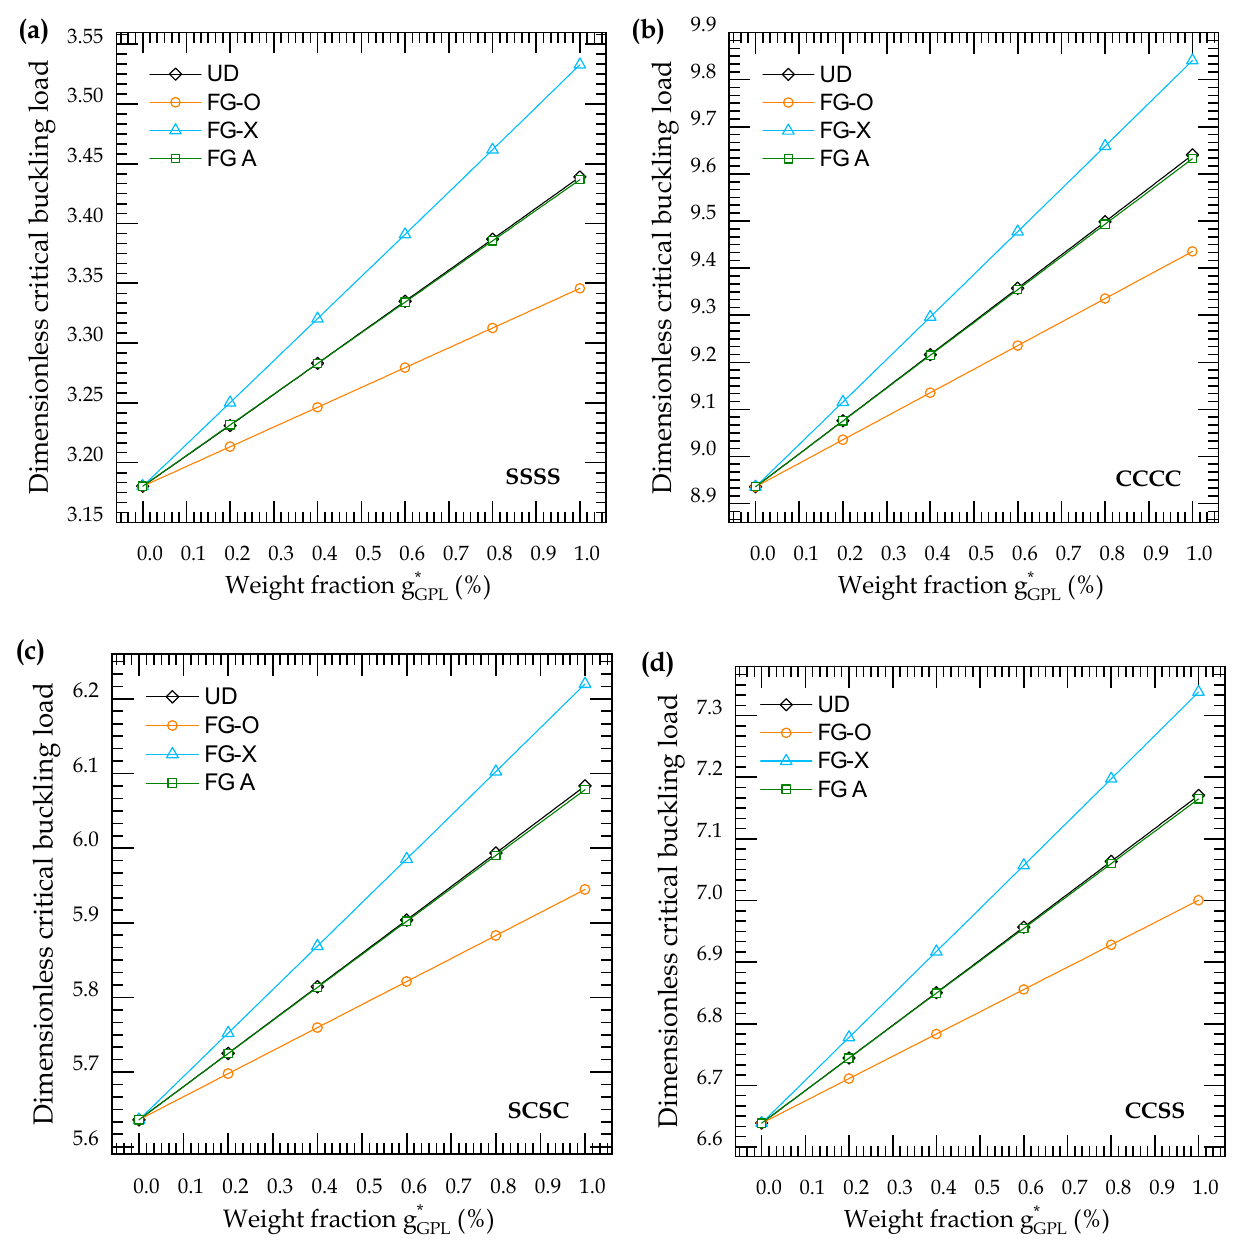
Figure 8. Influence of weight faction variation on dimensionless critical buckling load for various GPLs reinforcement patterns. ( a ) Full simply supported, ( b ) Full clamped supported, ( c ) Simply- Clamped-Simply-Clamped support, ( d ) Clamped-Clamped-Simply-Simply support